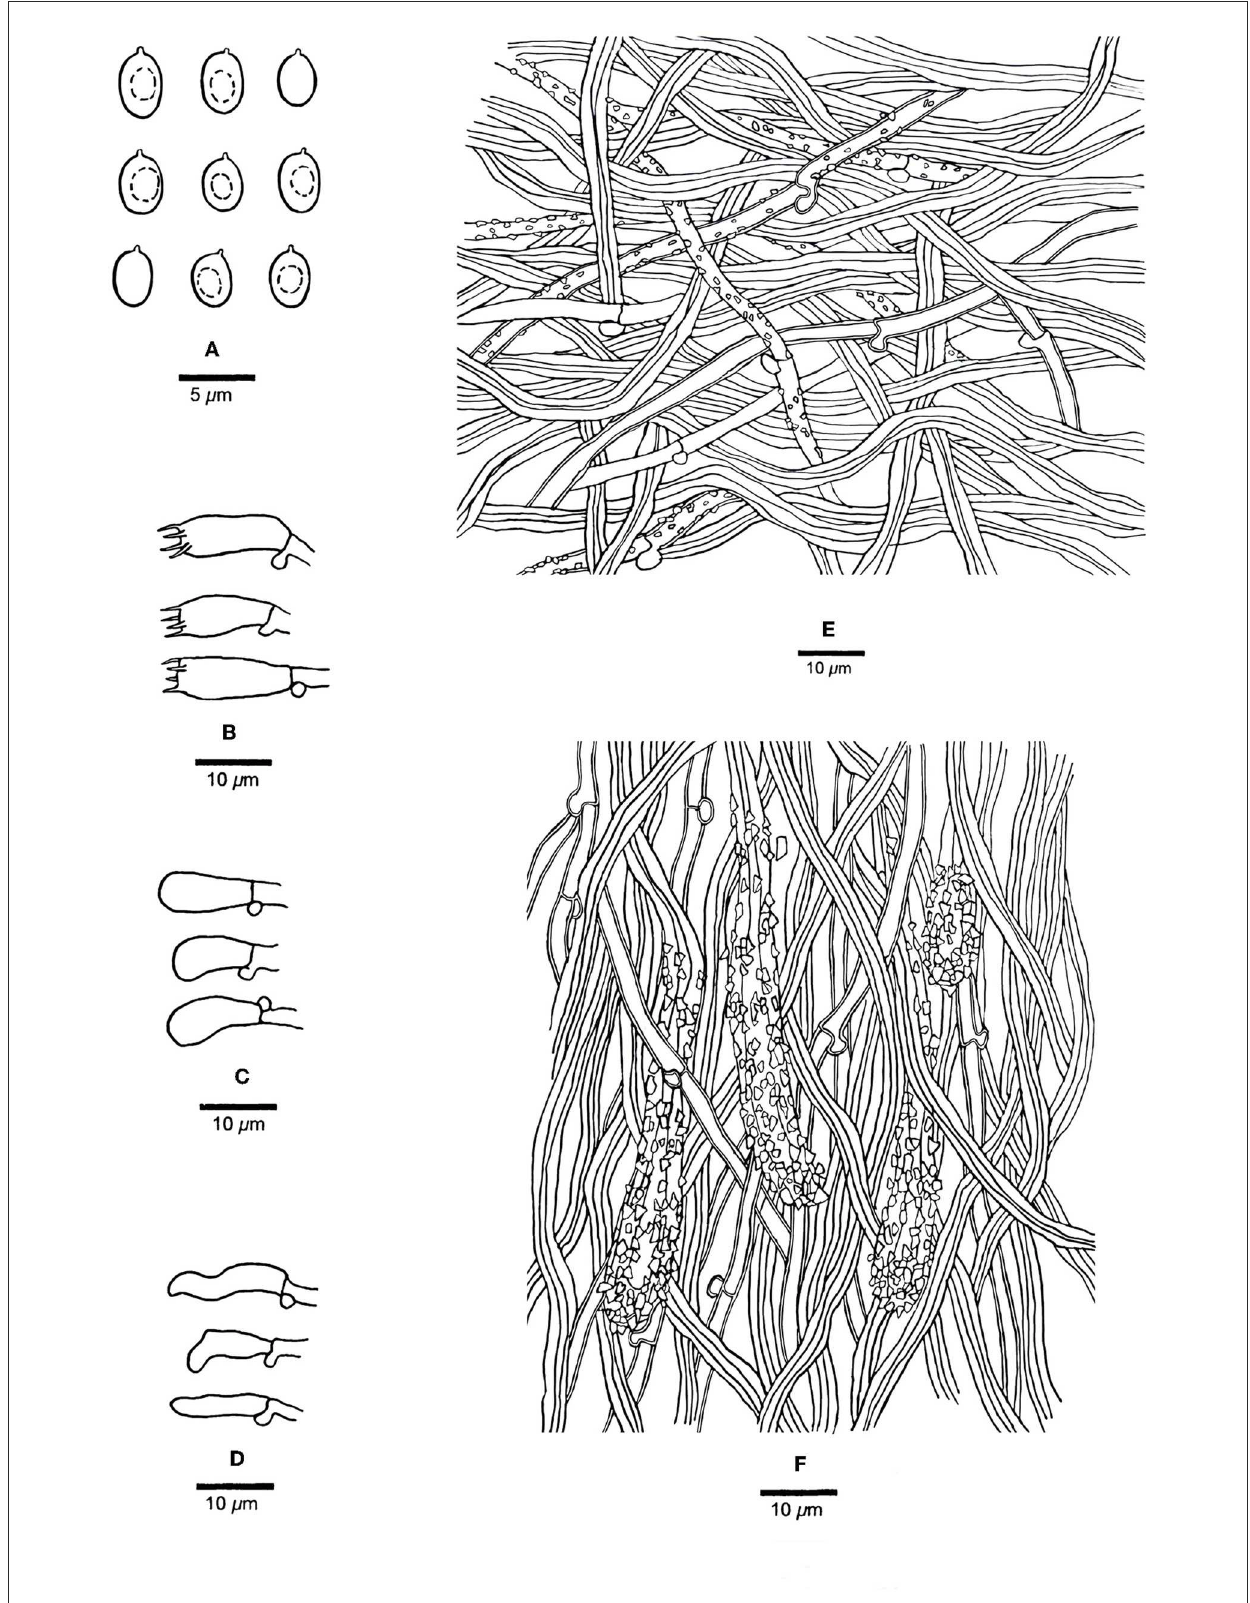
FIGURE5 Microscopic structures of Steccherinum juniperi (Holotype, Dai 23931). (A) Basidiospores. (B) Basidia. (C) Basidioles. (D) Cystidioles. (E) Hyphae from subiculum. (F) Hyphae from trama. Drawn by Meng